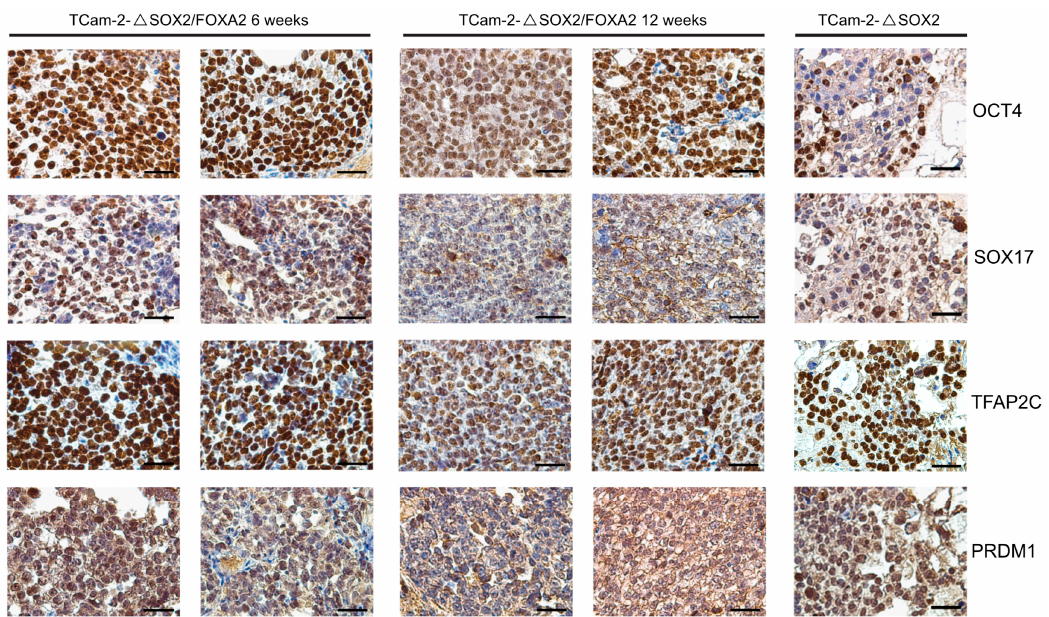
Figure 2. IHC staining of the pluripotency and seminoma markers OCT4, SOX17, TFAP2C and PRDM1 in TCam-2- Δ SOX2 / FOXA2 tumor tissues six and twelve weeks after xenografting. TCam-2- Δ SOX2 tumor tissue served as control (six weeks in vivo). Scale bars: 200 μ m.